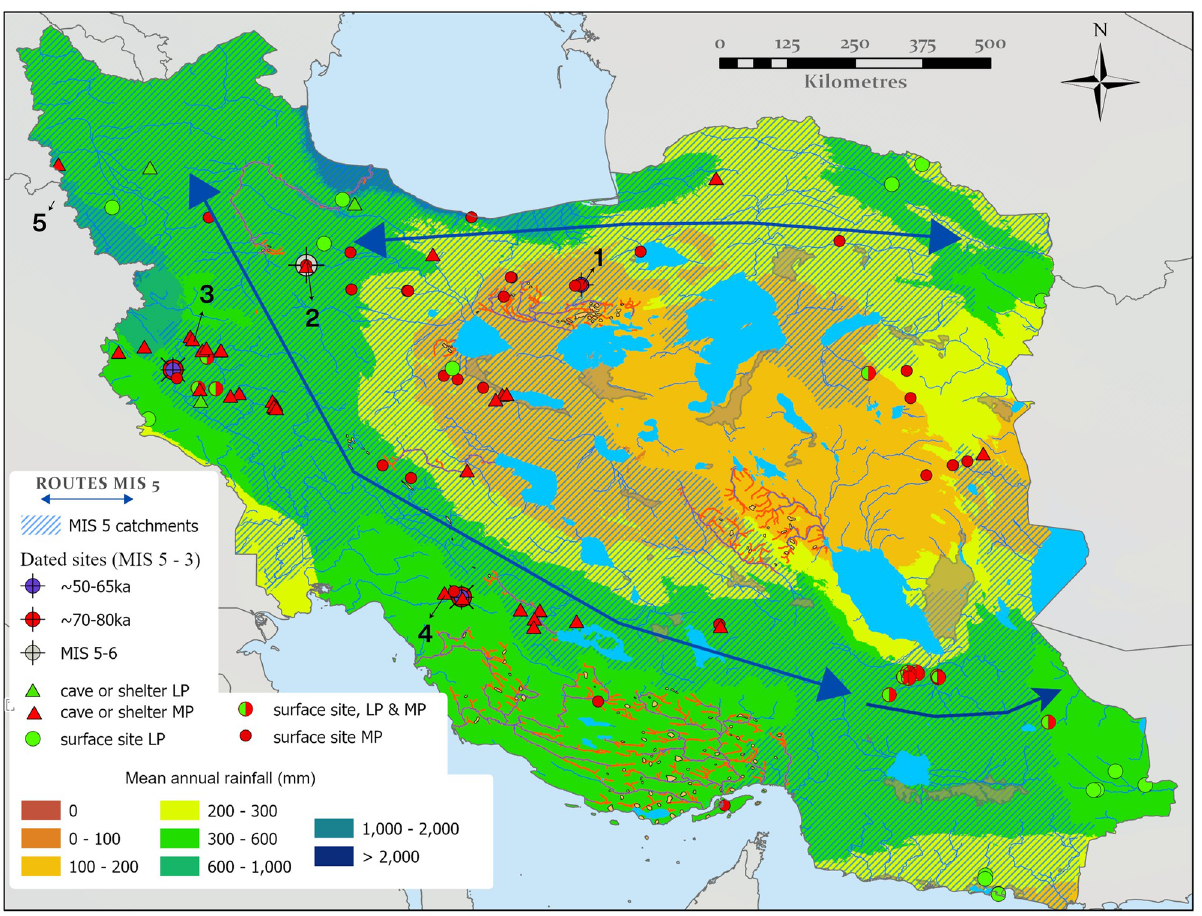
Fig 9. The distribution of LP and MP archaeological sites in relation to MIS 5 paleoclimate data. Sites which are discussed are numbered as follows; 1.Mirak, 2.Qaleh Kurd, 3.Bawa Yawan, 4.Ghar-e Boof, 5.Shanidar. The base map is the Otto-Bliesner et al. (130 ka) mean precipitation climate model [60]. This is overlain by catchments where MIS 5 humidity and active hydrology (hatched) are suggested by our data (see Fig 6). Simple representation of the broad routes through Iran are overlain as arrows. Map created by one of our authors (PSB).